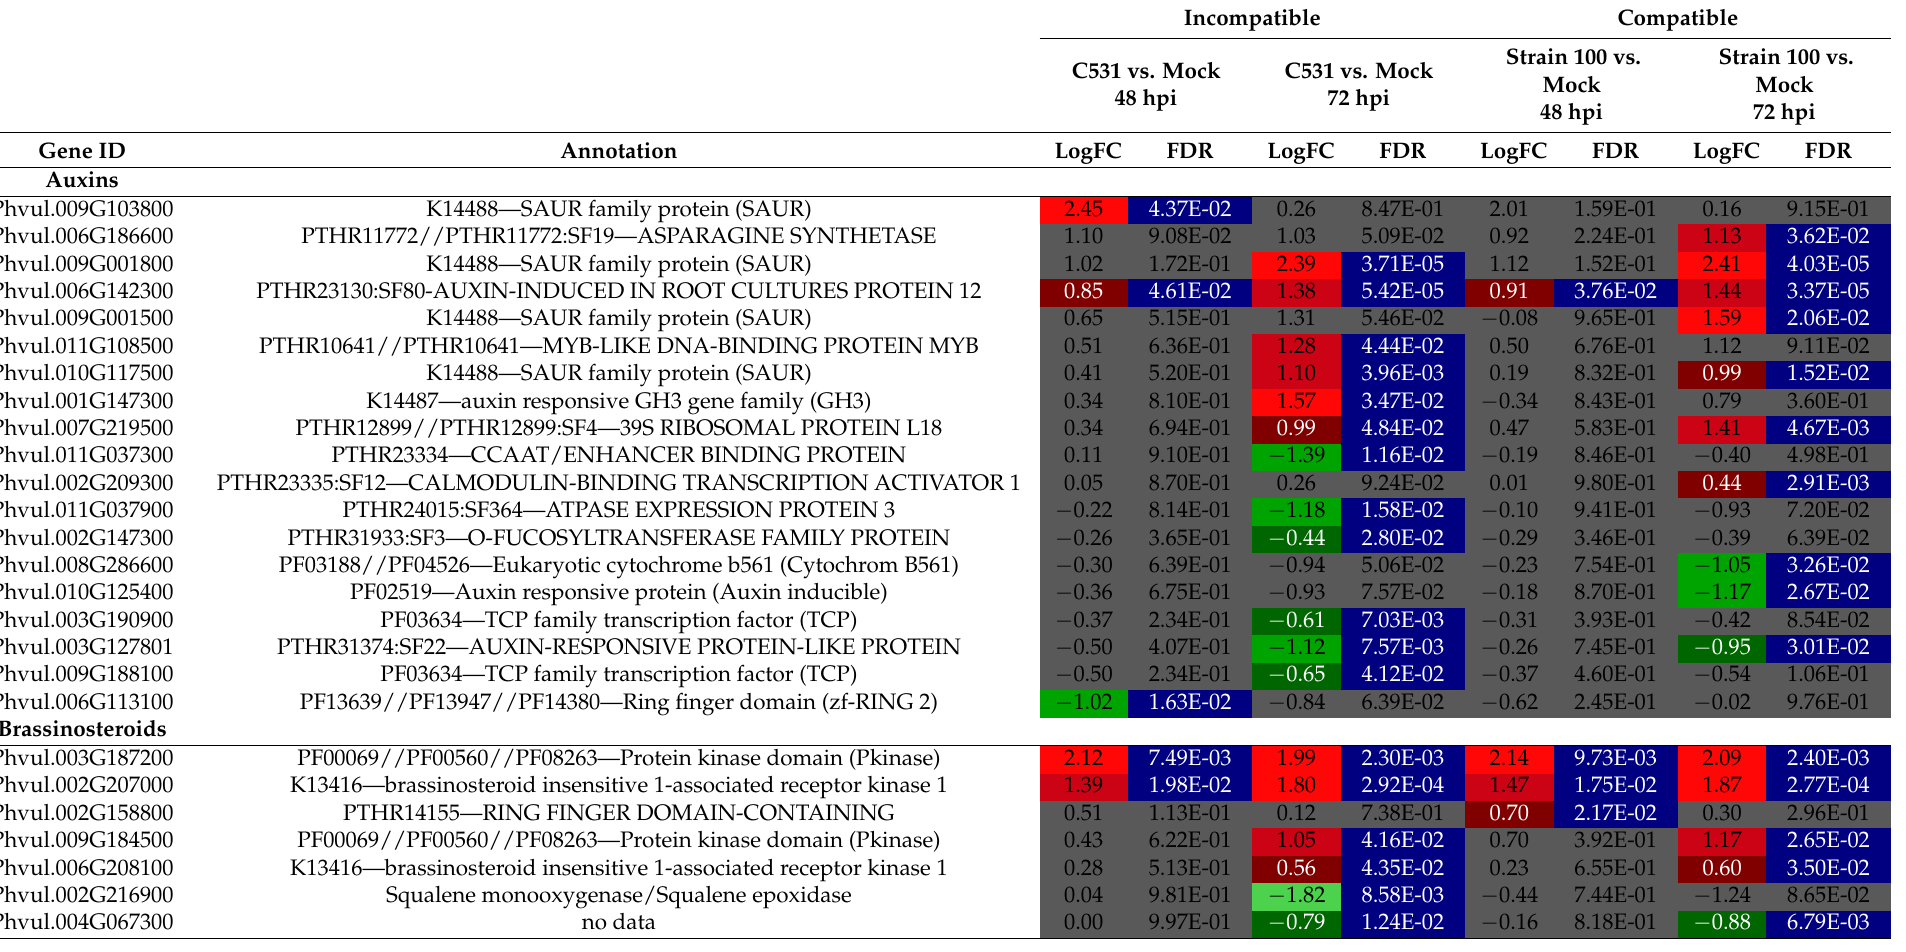
Table 3. List of defense-related plant hormones genes differentially expressed in at least one pairwise comparison, in compatible and incompatible interaction, at 48 hpi and 72